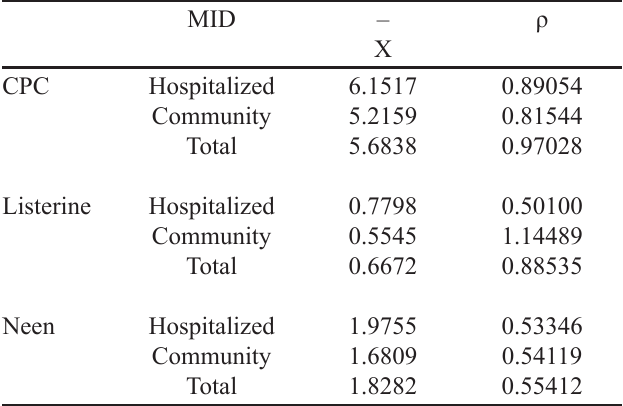
TABLE IV - Position measures and logarithm variability of the MID of the three antiseptic mouthwahses regarding community and hospital strains